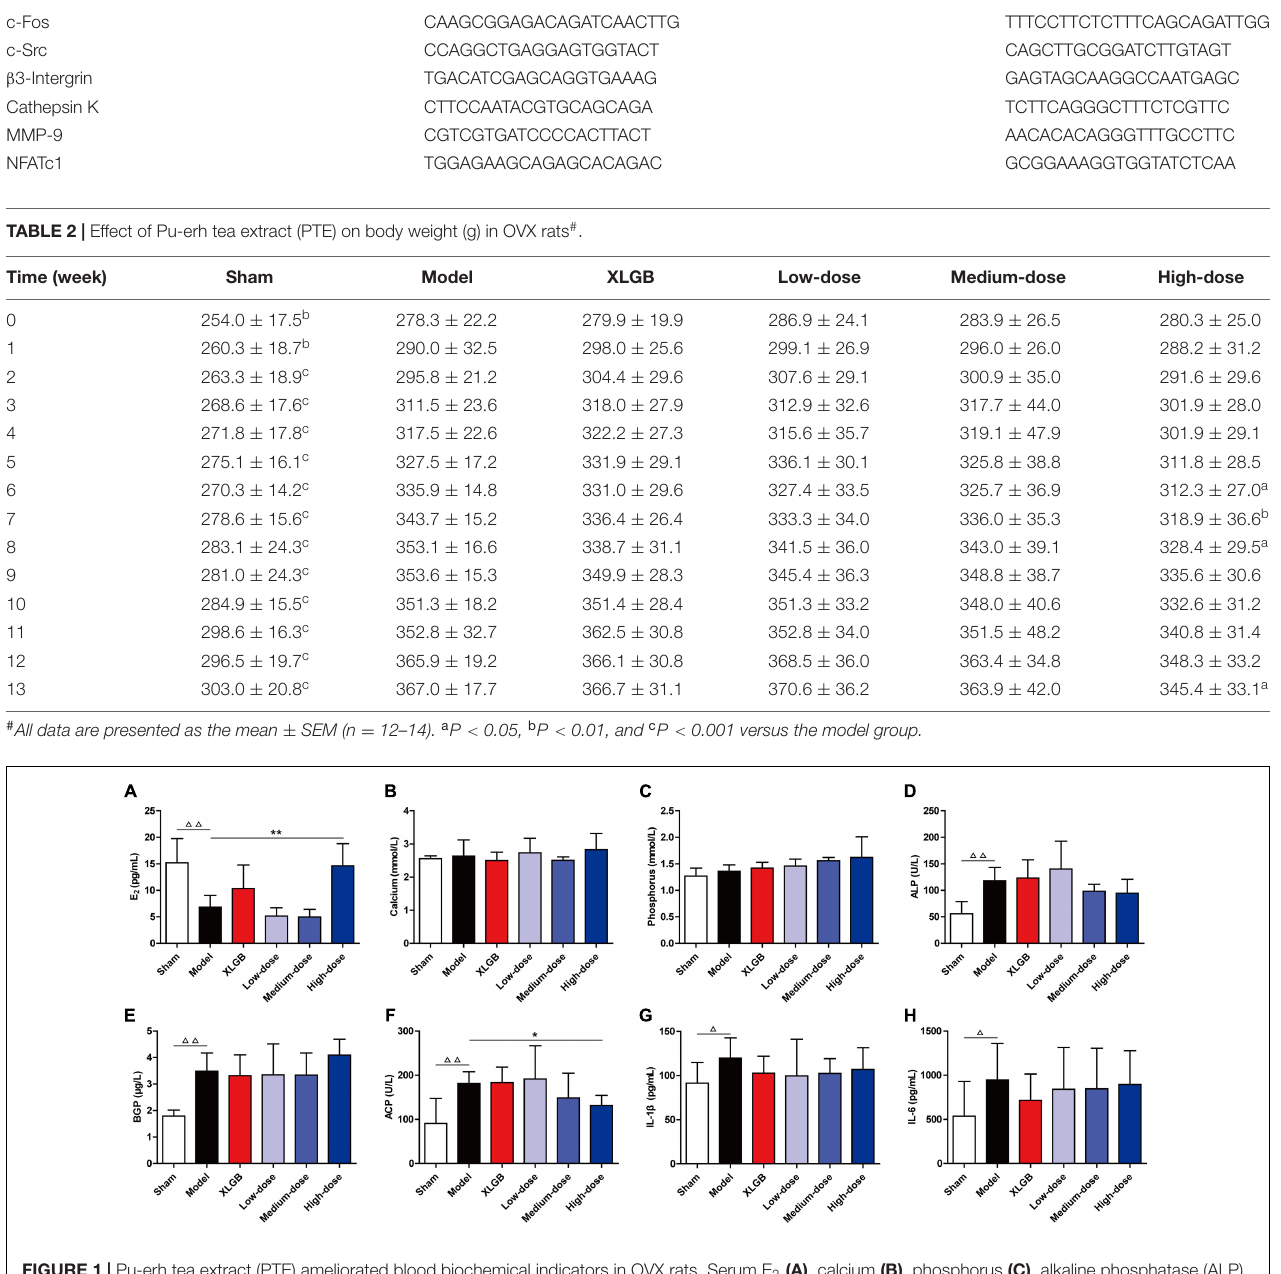
and the model group. However, treatment of OVX rats with PTE at a high-dose significantly increased E 2 levels compared with those in the model group ( P < 0.01; Figure 1A